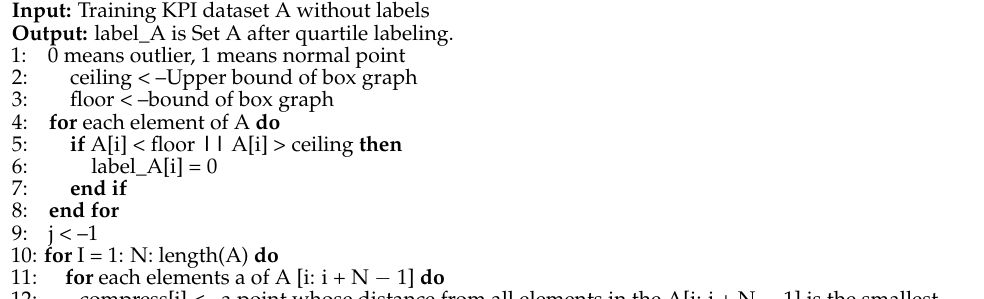
Algorithm 1: Compress Window Anomaly Period Test (create LNN training set)